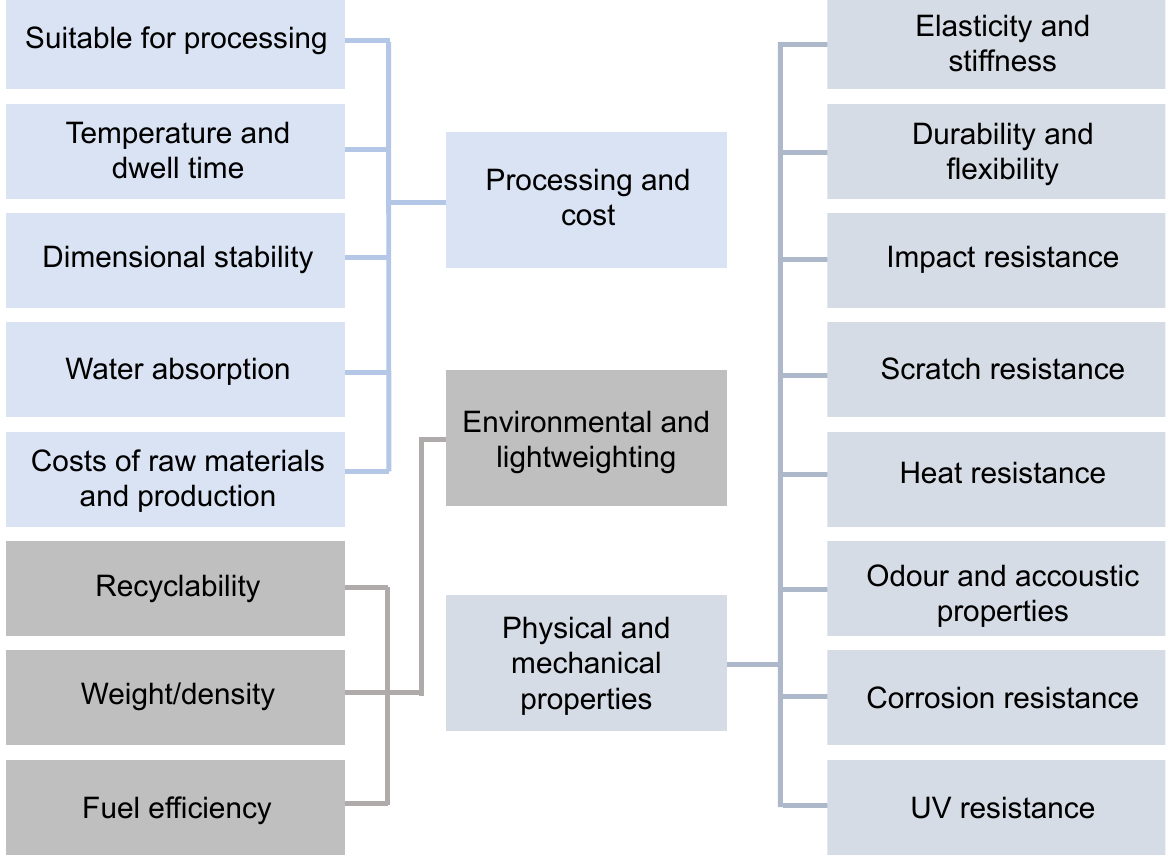
Figure 2. Plastic’s selection criteria for automotive applications.